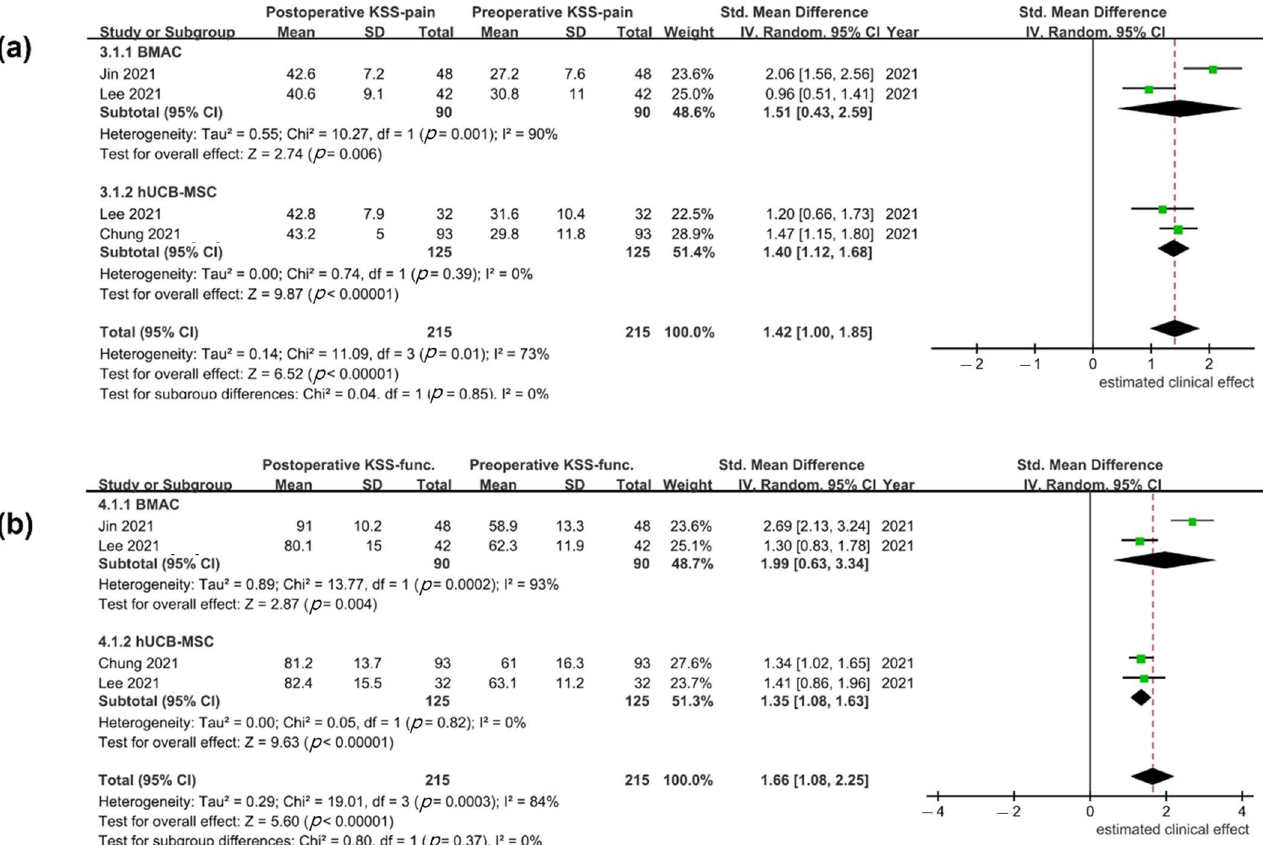
Figure 4. Estimated clinical effects of bone marrow aspirate concentrate (BMAC) and human umbilical cord blood-derived mesenchymal stem cells (hUCB-MSCs) in knee osteoarthritis (OA) patients treated with high tibial osteotomy (HTO) based on Knee Society Scores of ( a ) pain (KSS-pain) and ( b ) function (KSS-function) [24,34,38].